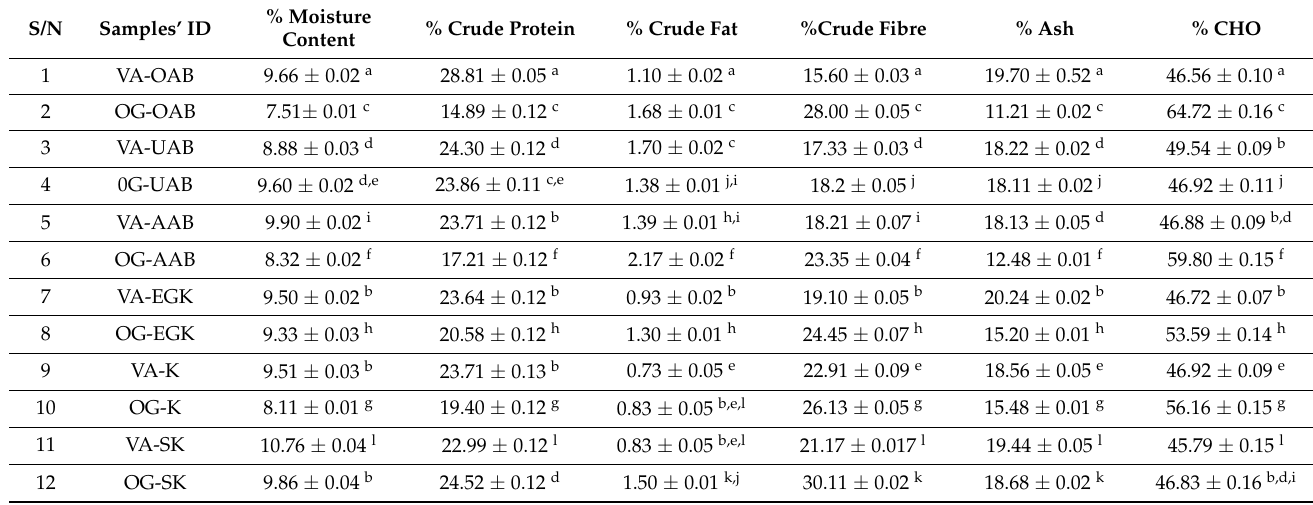
Table 3. Proximate composition of the vegetables on a dry weight (d.w.)